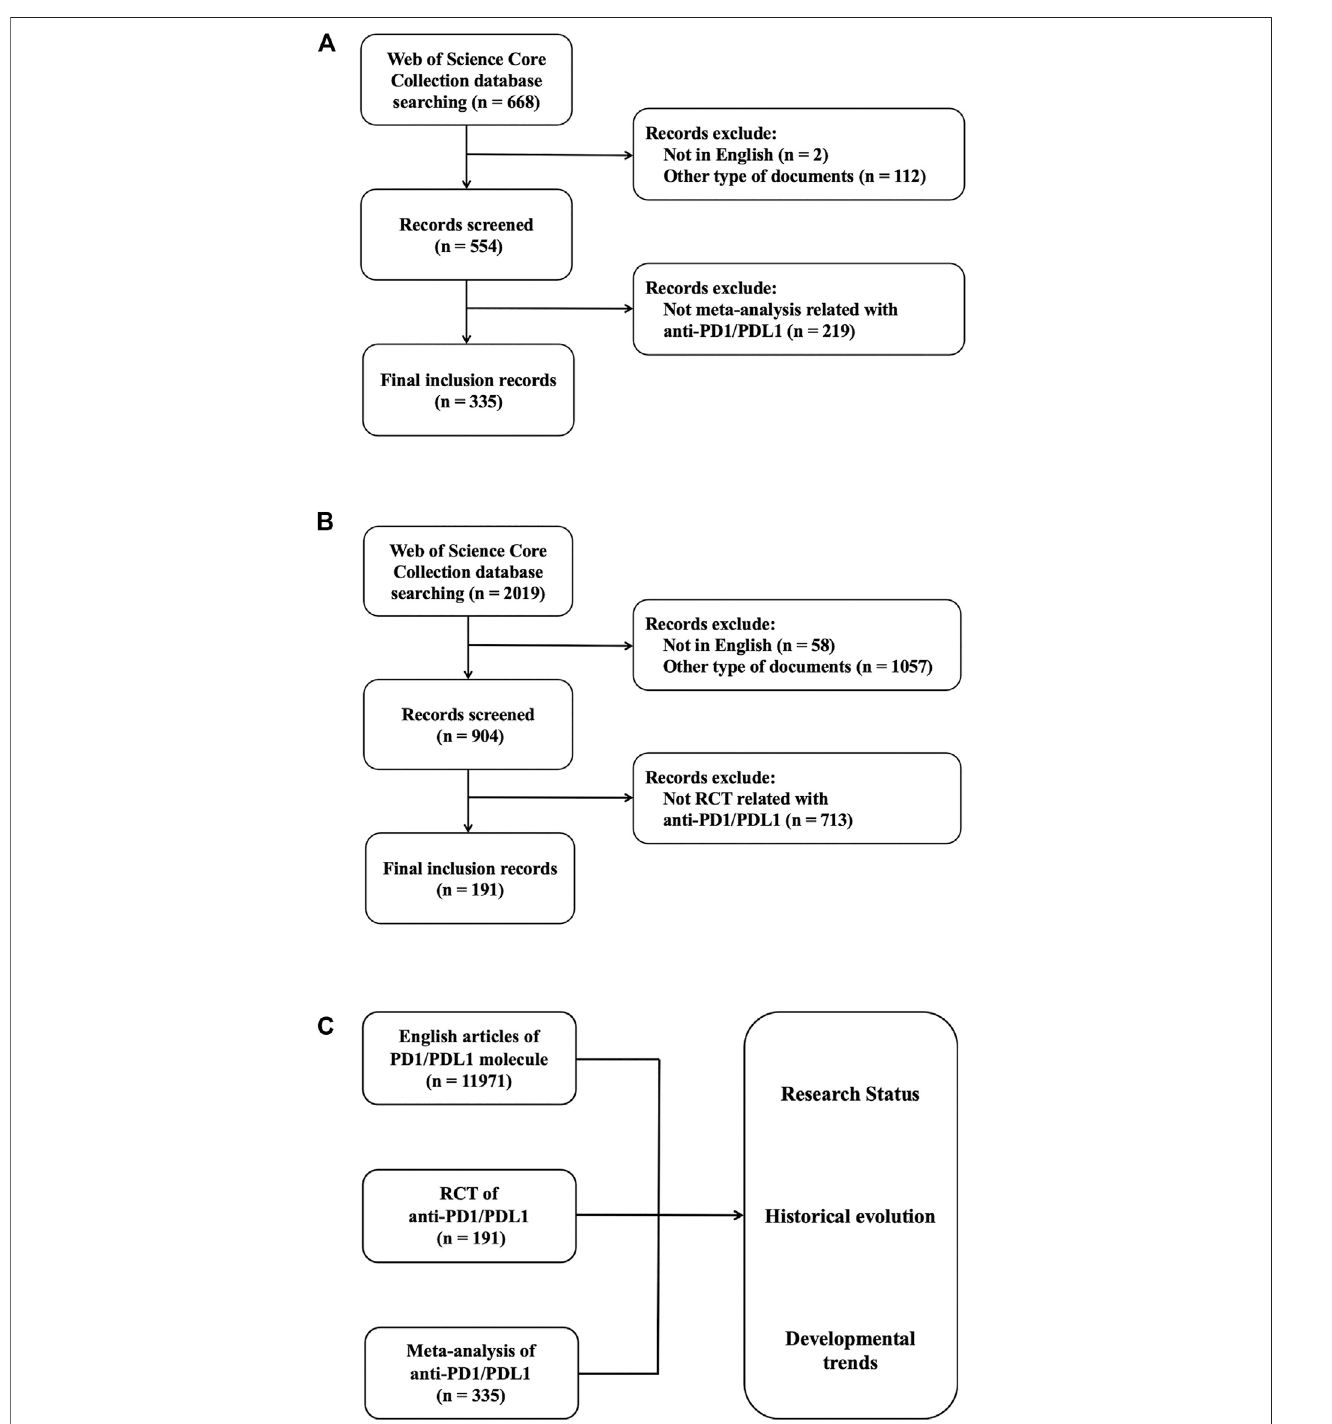
FIGURE 1 | Data fi ltration processing and results. Flowchart of inclusion and exclusion criteria for meta-analysis of anti-PD1/PDL1 (A) and RCT of anti-PD1/ PDL1 (B) . (C) Schematic diagram of main research contents.